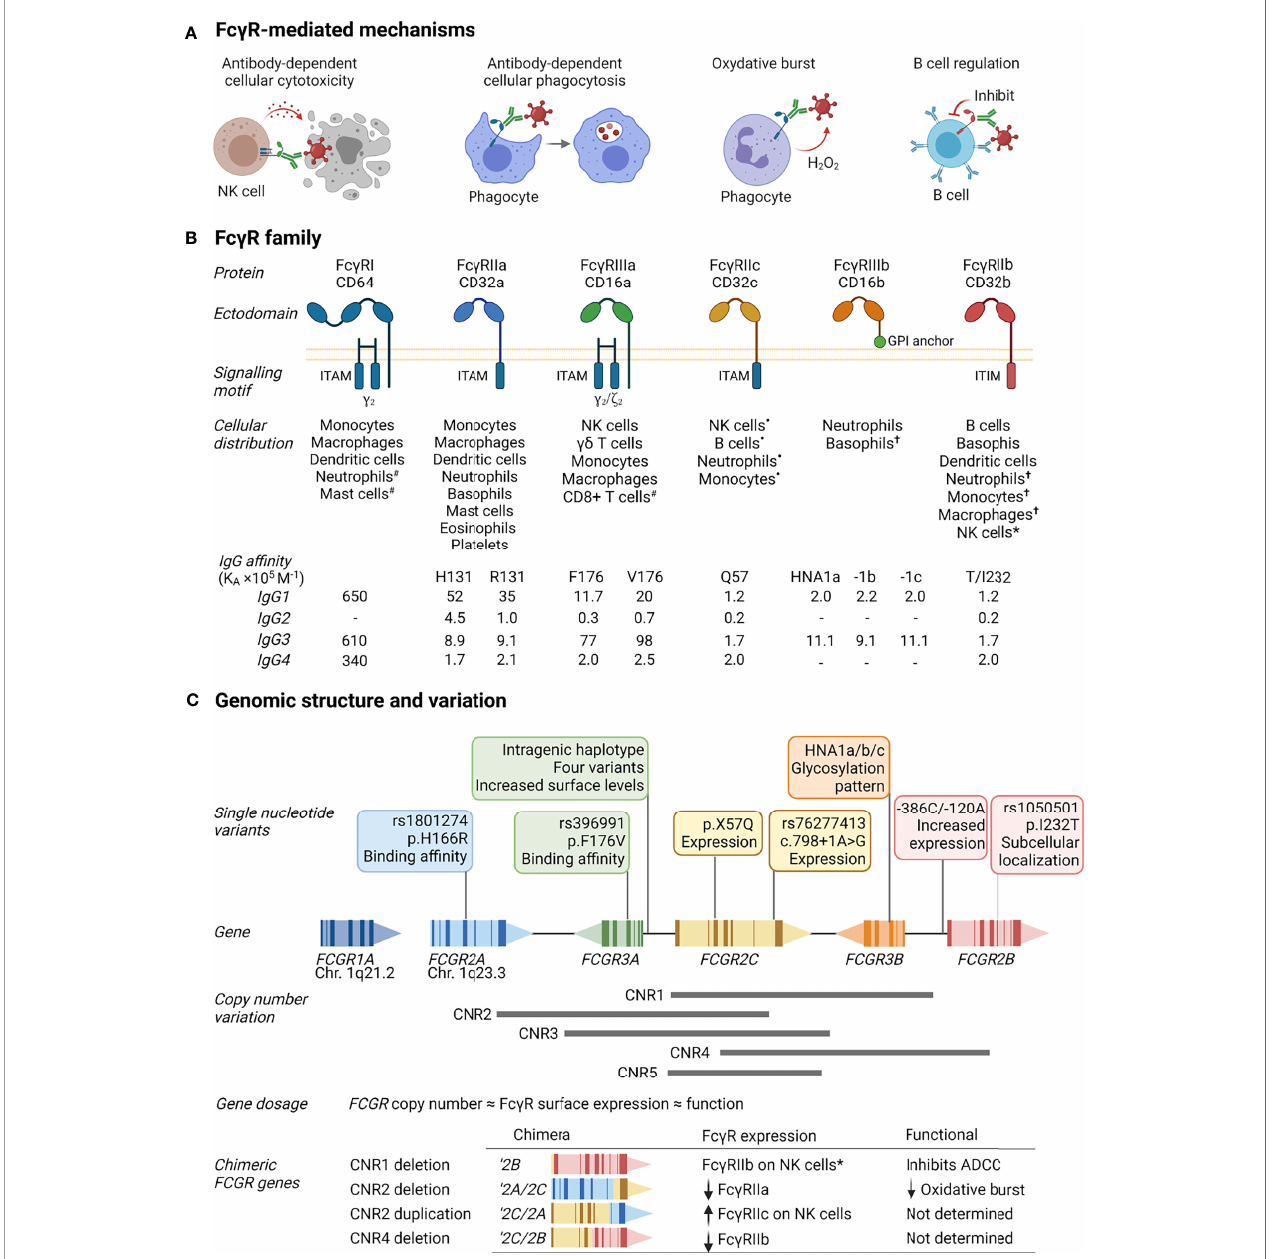
FIGURE 1 | Fc g R function, structure and variability. (A) Fc g Rs activate or inhibit immune mechanisms that include killing of infected cells through antibody-dependent cellular cytotoxicity, clearance of immune complexes through phagocytosis, release of reactive oxygen species [superoxide anion (O - 2 ) and hydrogen peroxide (H 2 O 2 )], and regulation of B cell activation through co-engaging the B cell receptor and inhibitory Fc g RIIb by immune complexes. (B) Fc g Rs comprise a family of receptors: Fc g RI, Fc g RIIa, Fc g RIIb, Fc g RIIc, Fc g RIIIa, Fc g RIIIb; also known by their cluster of differentiation (CD) markers CD64, CD32a, CD32b, CD32c, CD16a, and CD16b, respectively. The Fc g Rs IgG binding chain activates or regulates immune responses depending on its association with or inclusion of an immunoreceptor tyrosine activation motif (ITAM) or inhibitory motif (ITIM). Unique among Fc g Rs, Fc g RIIIb attaches to the cell membrane with a glycosylphosphatidylinositol (GPI) anchor. Each receptor has a speci fi c cell expression pro fi le and af fi nity for IgG and its subtypes (IgG1-4), shown as af fi nity constants (K A ×10 5 M -1 ); -, no binding. Expression patterns: # inducible expression; (cid:129) in individuals bearing the FCGR2C expression variants (20); † very low expression or expressed by rare subsets; *expressed in individuals bearing a FCGR2C- FCGR3B gene deletion. (C) The cluster of FCGR2A/B/C and FCGR3A/B genes on chromosome 1q23.3 that encode Fc g RIIa/b/c and Fc g RIIIa/b are polymorphic. Variants include nonsynonymous single nucleotide polymorphisms that alter the receptor ’ s binding af fi nity for certain IgG subtypes, determine expression of an otherwise pseudogene, increase surface expression, glycosylation, and subcellular localization. Large segmental duplications and deletions in the FCGR cluster further modify Fc g R expression levels and create chimeric genes that yield Fc g Rs with altered cellular distribution and/or function. Created with